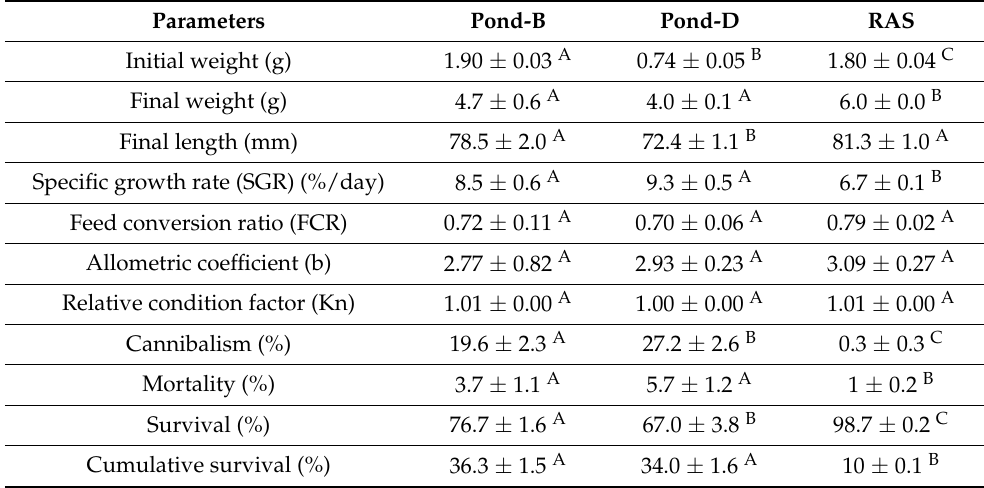
Table 3. Survival and morphometry of pond and RAS produced pike-perch Sander lucioperca juveniles at the end of post-habituation period, 70 DPH (means ± S. D., n = 3 tanks); results of post-hoc tests are provided as